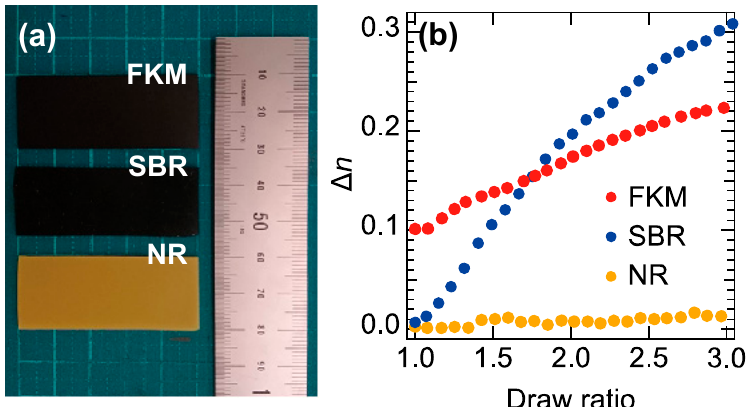
Figure 4. ( a ) Photograph of the FKM, SBR and NR samples; ( b ) Draw ratio dependence of the birefringence of the FKM (red circles), SBR (blue circles) and NR (orange circles) samples. Part of this figure is reproduced from M. Okano et al . Sci. Rep. 6 , 39079 (2016) [25]. Licensed under CC BY 4.0.